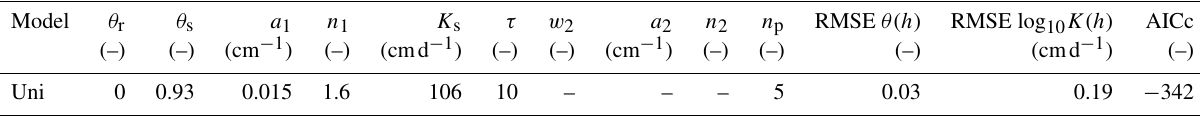
Table 2. Parameter results for the soil hydraulic properties function of the unimodal (uni) model saturation function; the parameter names are explained in the text.